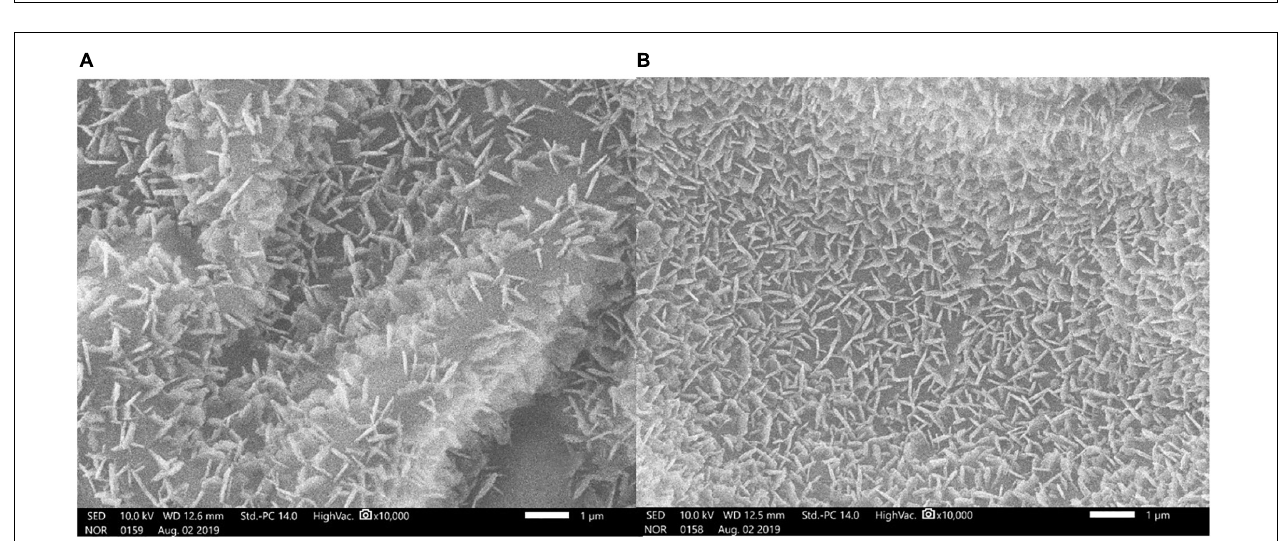
FIGURE 6 | Comparison of real-time PCR data and RNA-Seq differential gene expression data of cluster bean cultivar RGC-1025.